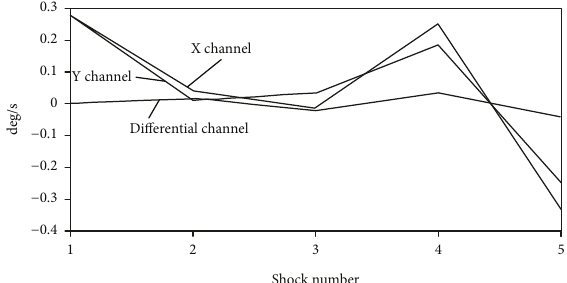
Figure 7: Change of biases after 20 g shocks along IA.